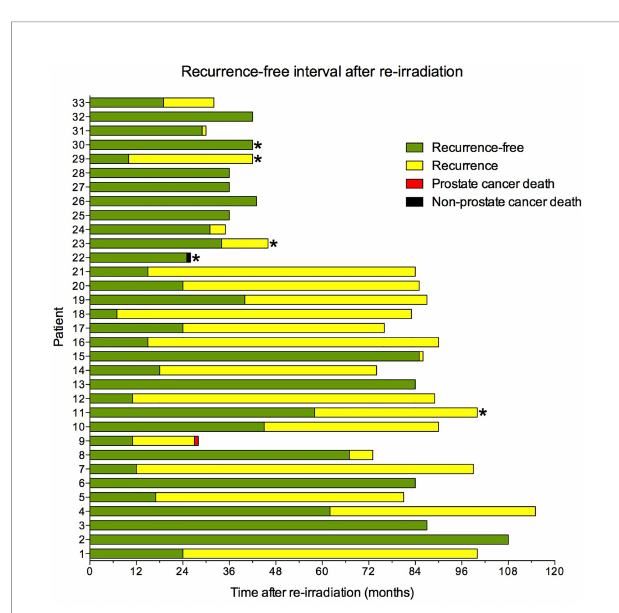
FIGURE 7 | Recurrence-free interval after re-irradiation. *Patients who received androgen deprivation treatment at salvage